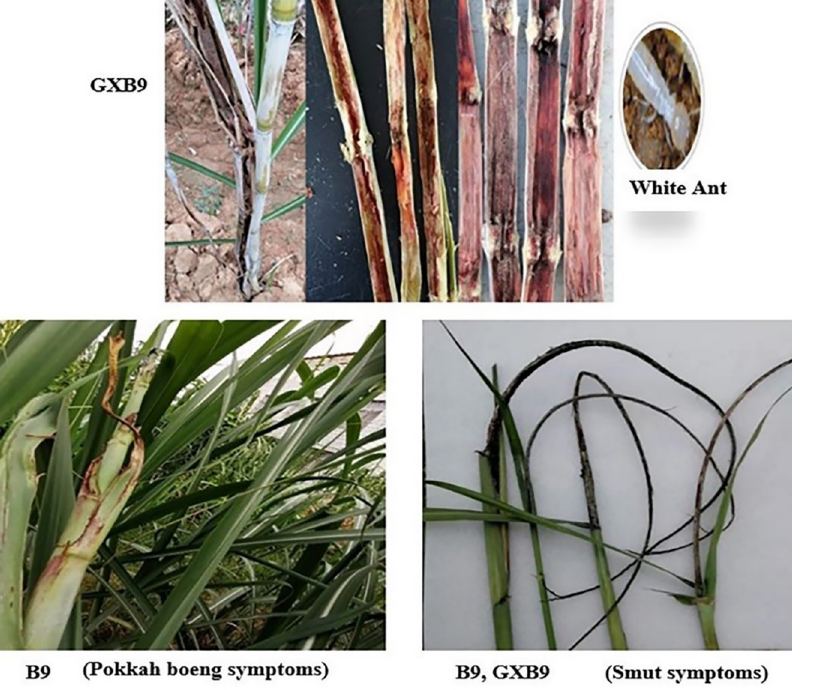
Fig 10. Occurrences of some diseases and pests attack in sugarcane plants of GXB9 and B9.